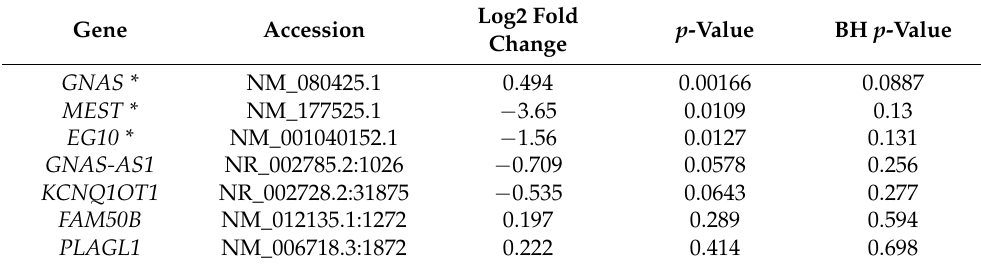
Table 2. nCounter Nanostring expression profile of the imprinted genes expressed in LCLs. Log2 Fold p -Value BH p -Value Gene Accession Change GNAS * NM_080425.1 0.494 0.00166 0.0887 MEST * NM_177525.1 − 3.65